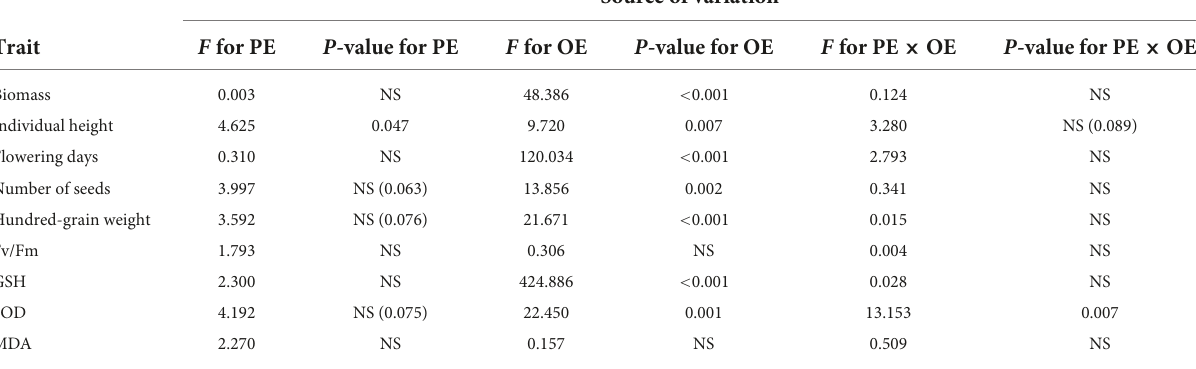
downregulated) in intersection of three comparison pairs (Cd185 vs. CK, CK-S vs. CK-CK, and S-CK vs. CK-CK). A total of 315 upregulated and 86 downregulated TMGs were identified ( Figure 5A and Supplementary Table 5 ), with the expression pattern shown in Figure 5B . The GO enrichment analysis showed that TMGs participated in some important biological processes. For example, the downregulated TMGs were involved in biological processes such as response to abscisic acid (ABA), the salicylic acid-mediated signaling pathway, and regulation of multicellular organism growth ( Figure 5C ), whereas the upregulated TMGs participated in the biological processes of cell wall biogenesis, response to light stimulus, the hydrogen peroxide catabolic process, and DNA methylation of cytosine within a CHH sequence ( Figure 5D ). According to expression pattern, the TMGs were further compared with the S-S vs. CK-S results to identify the TMGs that may enhance expression under the S-S environment when G1 and G2 both experienced Cd treatment. As a result, a total of 17 TMGs (7 downregulated and 10 upregulated) that showed enhancement of expression under the S-S environment were identified, and the detailed information was provided in Supplementary Table 6 .